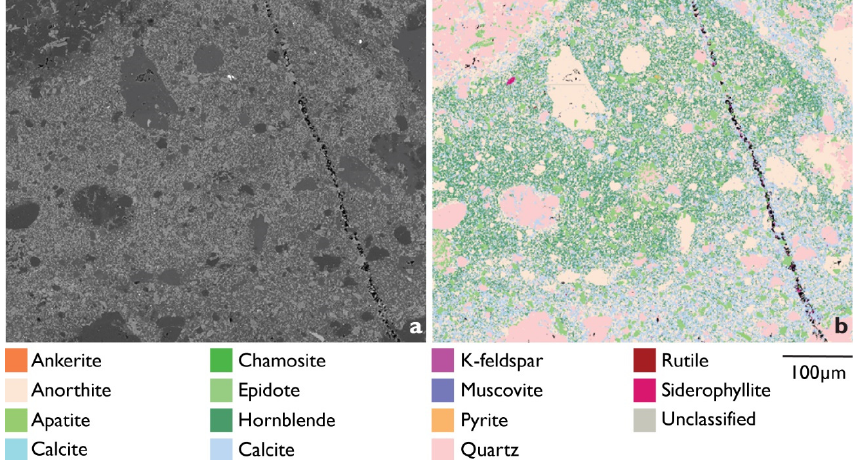
Figure 2. Large area overview image of the scanned sample area. ( a ) Displays the high ‐ resolution BSE image ( b ) Displays the false ‐ colored mineral map and key, displaying the mineralogy across this